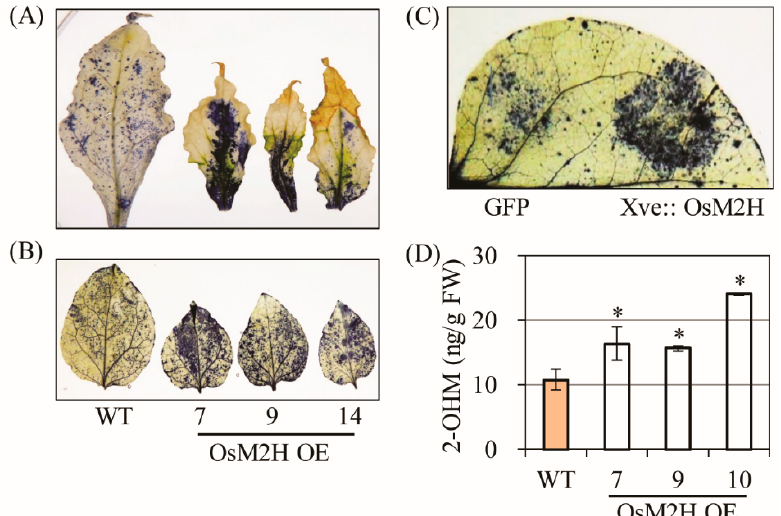
Figure 2. ( A ) Determination of superoxide levels by nitrotetrazolium blue (NBT) staining in upper leaves from 12-week-old transgenic tobacco plants. ( B ) Determination of superoxide levels by NBT staining in 6-week-old lower transgenic tobacco leaves. ( C ) Determination of superoxide levels by infiltrating Agrobacterium strains harboring the XVE-inducible OsM2H-Cherry or 35 s-GFP-HA plasmids. Six-week-old wild-type (WT) tobacco leaves were induced by estradiol (10 µ M) treatment, followed by 10 h of incubation prior to NBT staining. ( D ) High-performance liquid chromatography (HPLC) quantification of 2-OHM in upper leaves of tobacco (Figure 1B). Error bars indicate the standard deviation of three biological replicates. Asterisks (*) indicate significant differences from the WT control, determined using Tukey’s post-hoc honest significant difference (HSD) test at a level of p < 0.05.